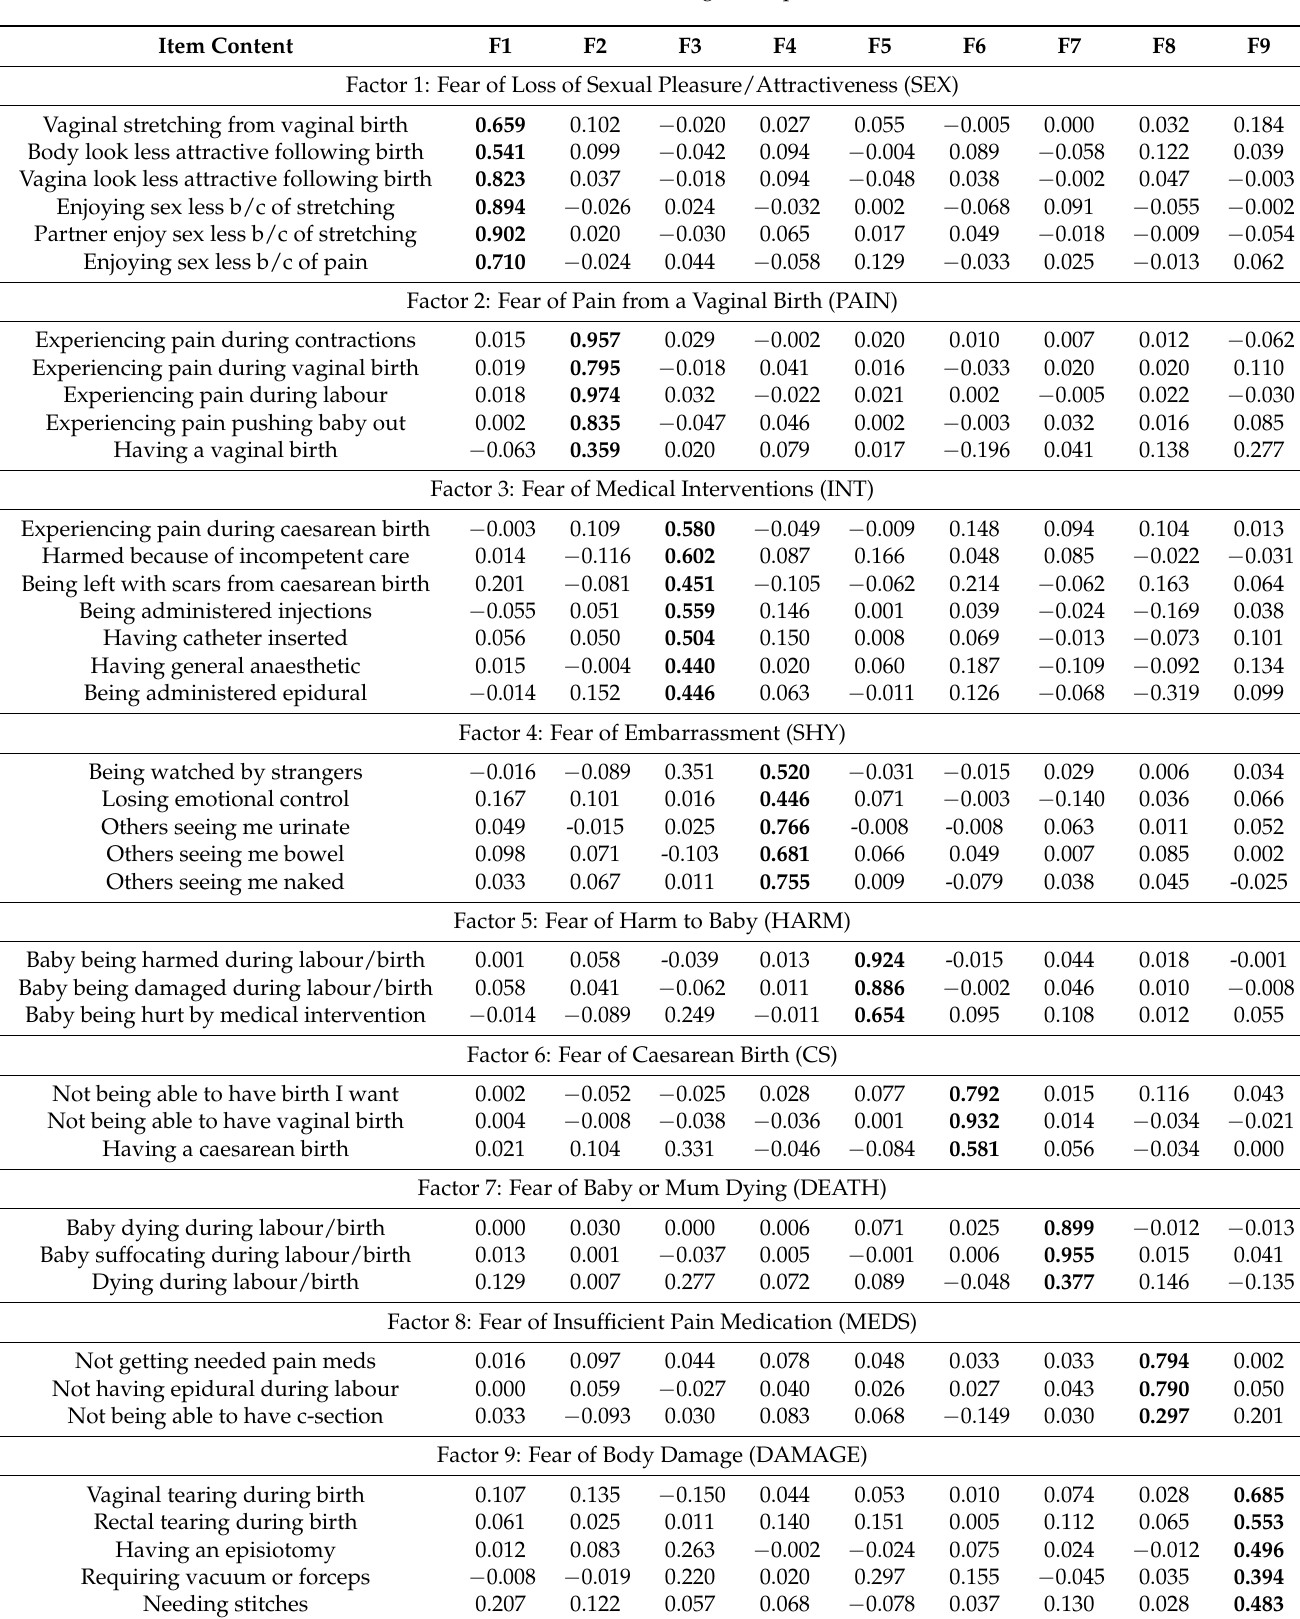
Table 4. Oblimin-rotated factor loadings from pattern matrix of 9-Factor CFQ